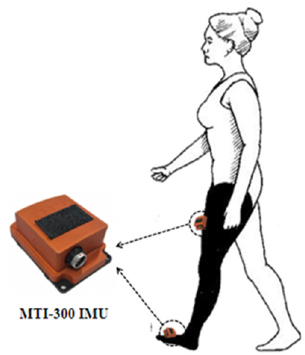
Figure 4. Distributed structure for inertial information acquisition .